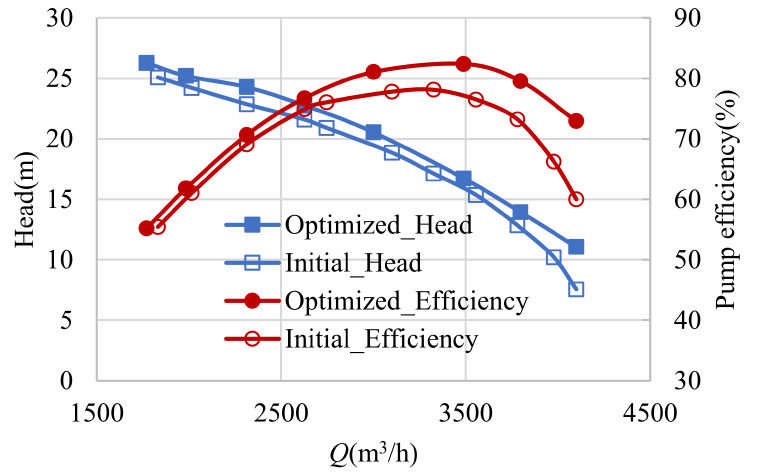
Figure 18. Comparison of experimental performance curves between initial and optimized